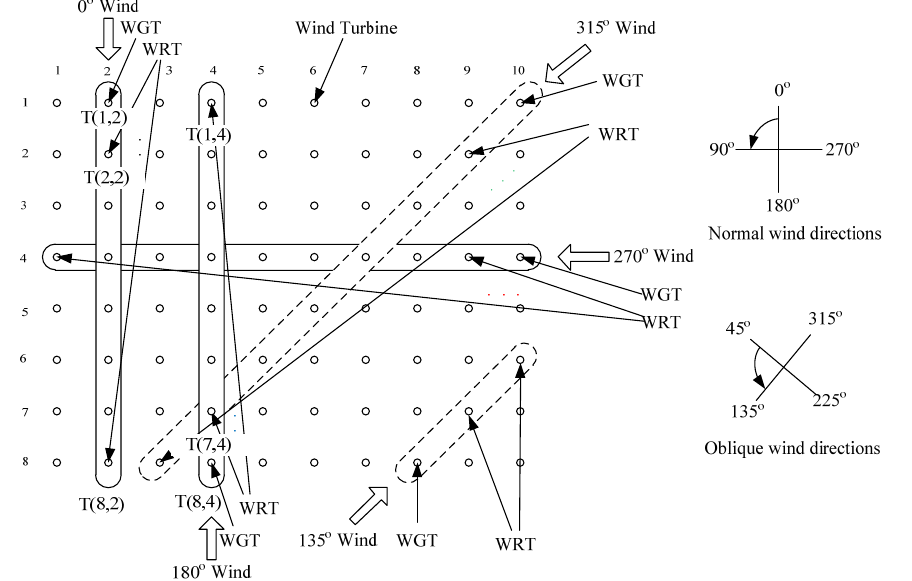
Figure 4. Normal and oblique wind delivery in the Horns Rev OWF, Denmark. Note, WGT is the wind energy-giving turbine, and WRT is the wind energy-receiving